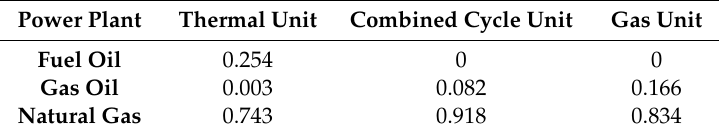
Table A4. Conversion matrix input energy to fuel power plants.